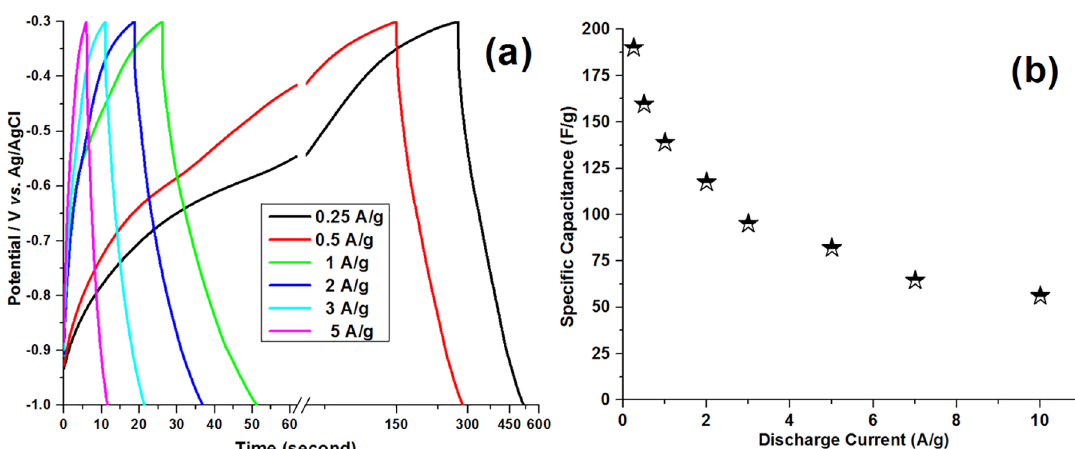
Fig. 6. (a) GCD Yofiles of Y-IONPs electrode and (b) is calculated SCs at the different current loads of 0.25 to 5 A g